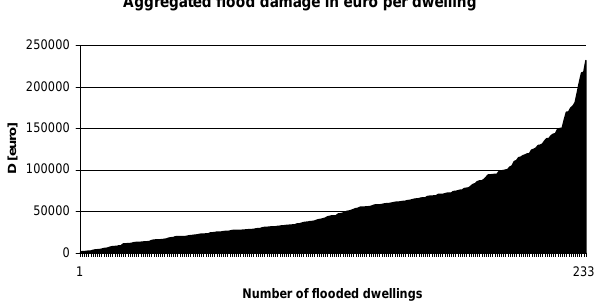
Figure 6. Damage (D) in € in ascending order. Data source: Amt der NÖ Landesregierung, Fig. 6. Damage ( D ) in C in ascending order. Data source: Amt Abteilung Landwirtschaftsförderungen, 2006. der N ¨O Landesregierung, Abteilung Landwirtschaftsf¨orderungen